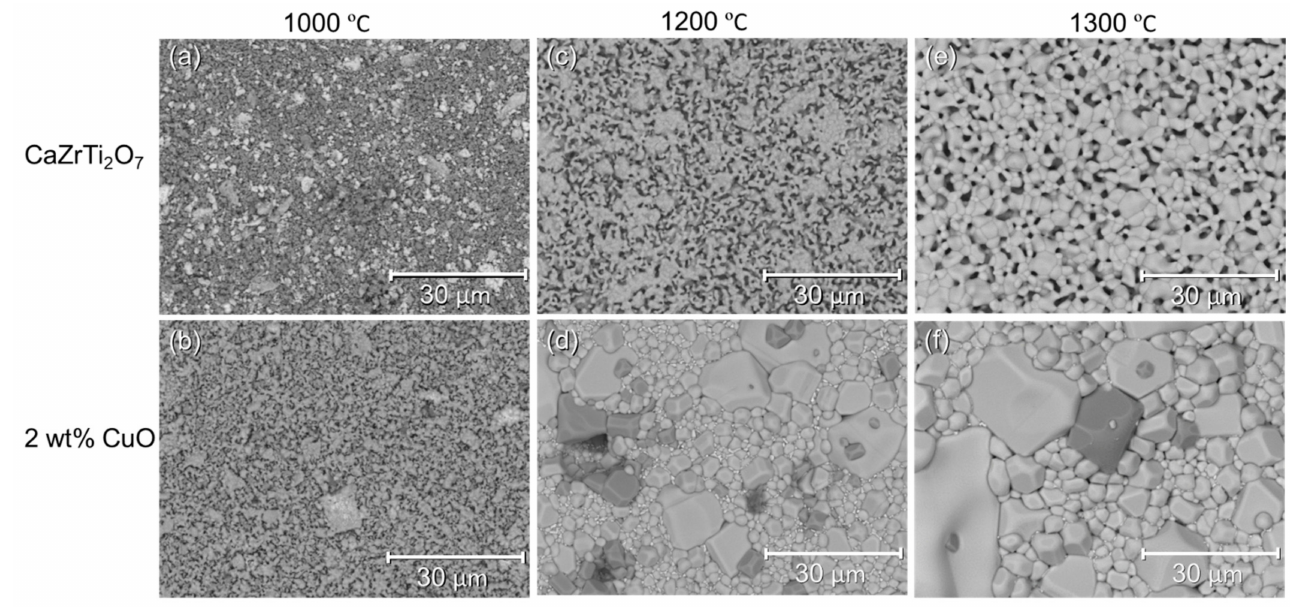
Figure 4. Scanning electron micrographs of ( a ) undoped CaZrTi 2 O 7 sintered at 1000 ◦ C; ( b ) 2 wt.% CuO sintered at 1000 ◦ C; ( c ) undoped CaZrTi 2 O 7 sintered at 1200 ◦ C; ( d ) 2 wt.% CuO sintered at